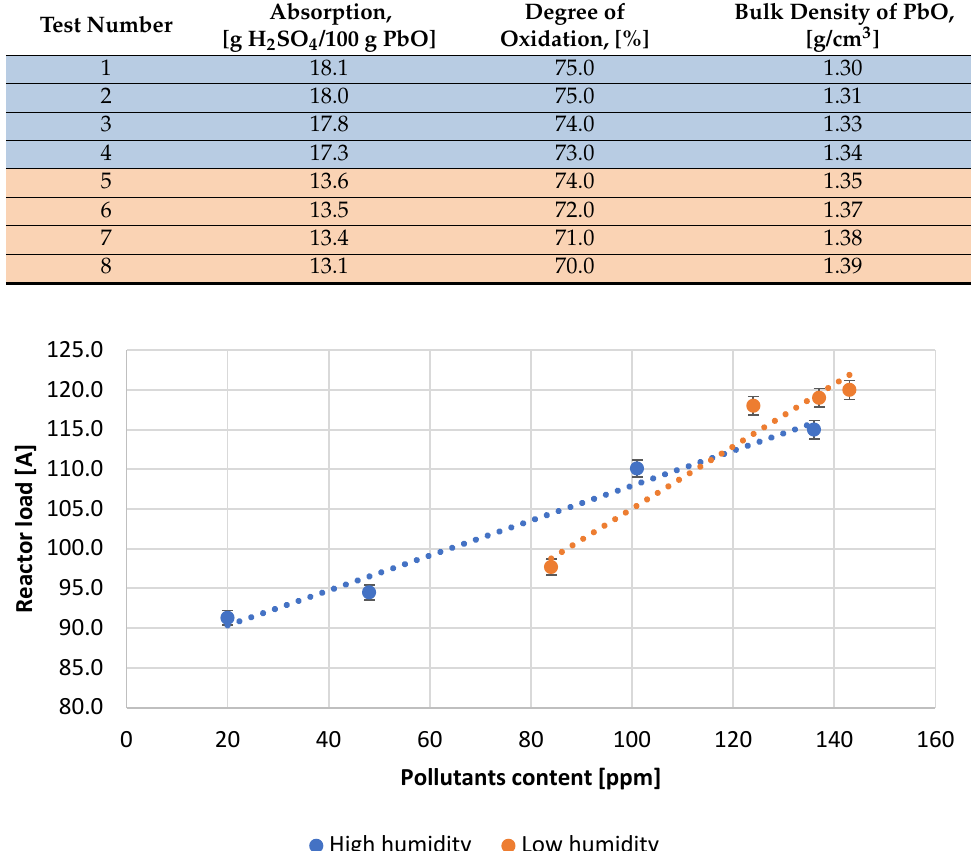
Figure 3. Dependence of reactor load on the pollutants content.